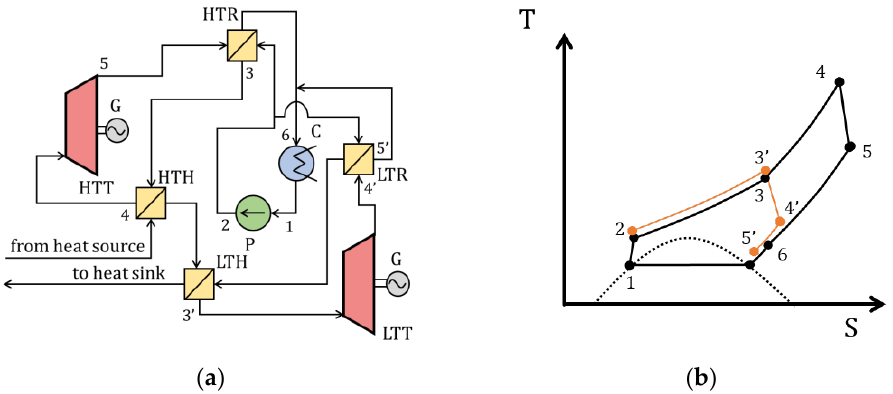
Figure 10. Cascade Rankine cycle: ( a ) schematic diagram; ( b ) T – S diagram [19]. HTT — high-temperature turbine; LTT — low-temperature turbine; G — generator; HTR — high-temperature regenerative heat exchanger; LTR — low-temperature regenerative heat exchanger; P — pump; LTH — low-temperature heater; HTH — high-temperature heater.